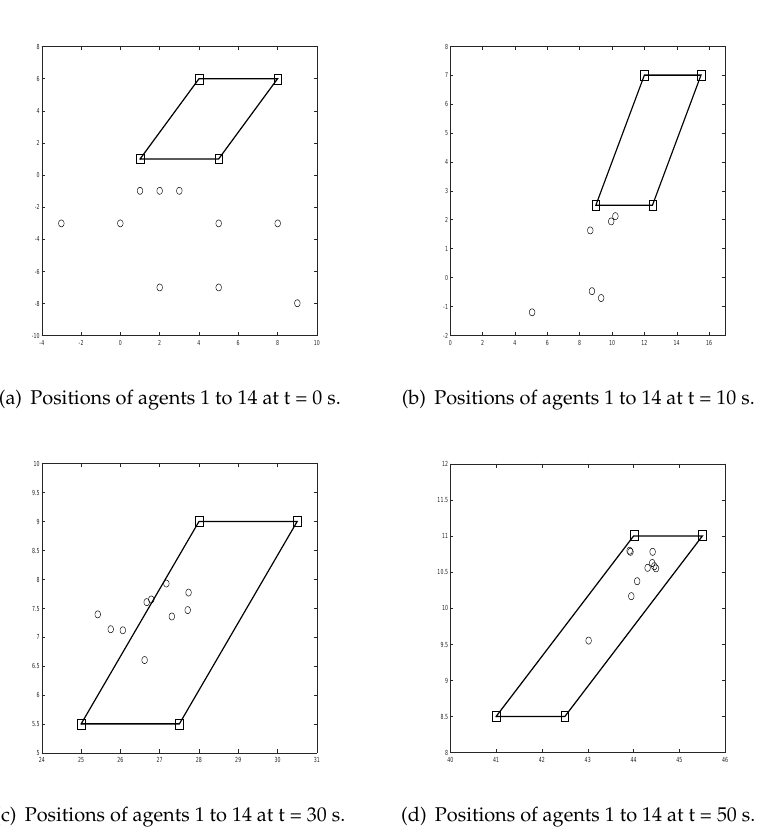
Figure 6. Positions of agents 1 to 14 using Algorithm 2 with τ = 0.5, where squares denote leaders and circles denote